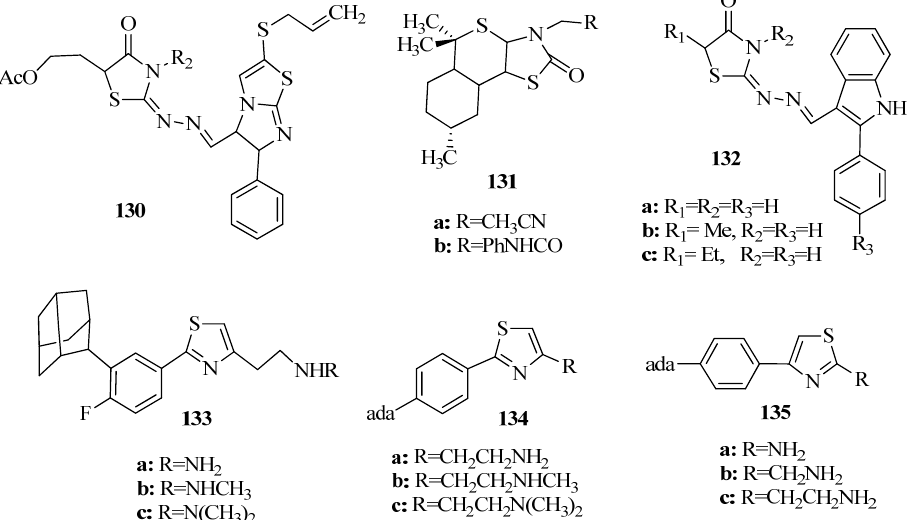
Figure 54. Structures of thiazole-based derivatives ( 130 – 132 ) and 2,4-disubstituted arylthiazoles ( 133 – 135 ).